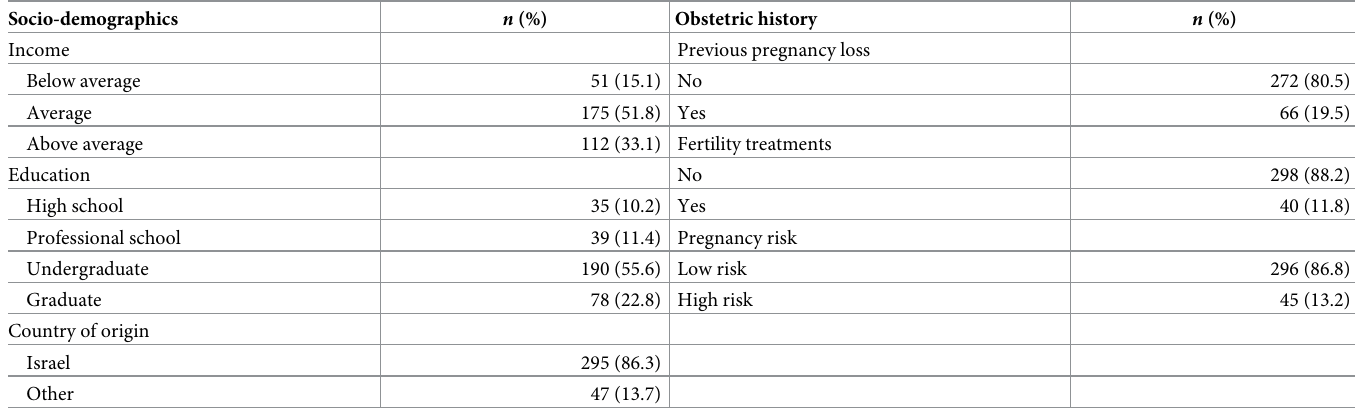
Table 1. Socio-demographic characteristics of participants ( N = 342).